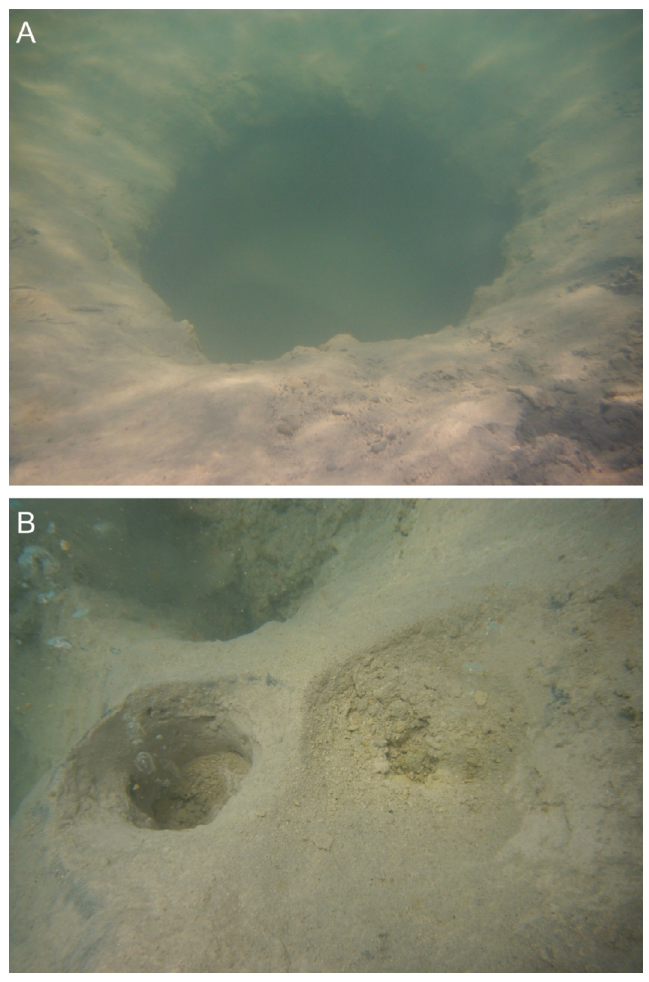
Figure 7. Underwater field photographs: a) External rim of the widest (4 m diameter) vent at whose bottom several active emission points of CO are located; b) Close view of a CO emission point with rising gas 2